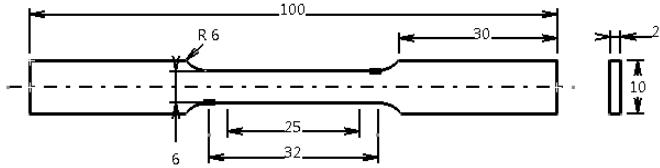
Figure 2. Tensile test specimen dimensions (in mm).